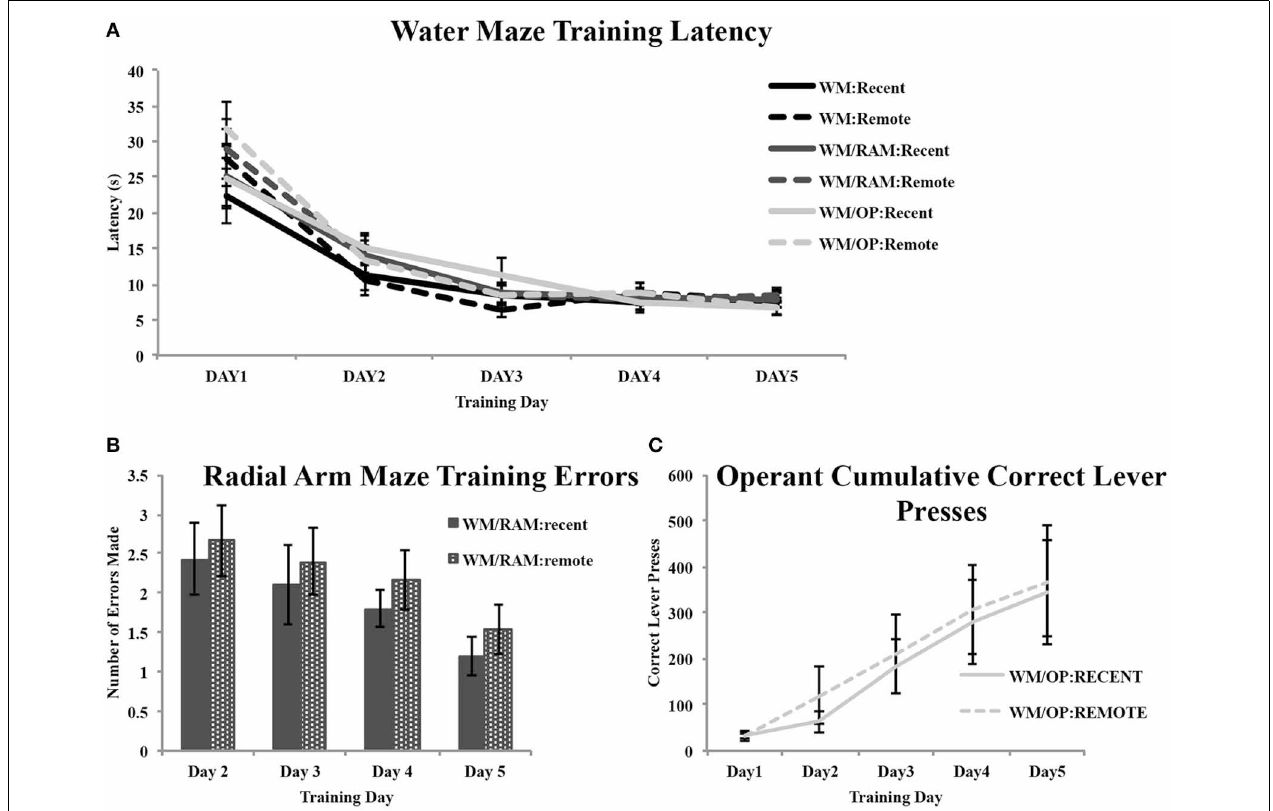
FIGURE 2 | Behavioral training data. (A) All rats received water maze training. Average latencies to reach the hidden platform during the 5 days of water maze training are displayed. A main effect of day was found. Latency to reach the hidden platform decreased across training day indicating an improvement in performance. No main effect of behavior or time was found. (B) Average number of errors (unbaited arm entries and re-entries) made in the